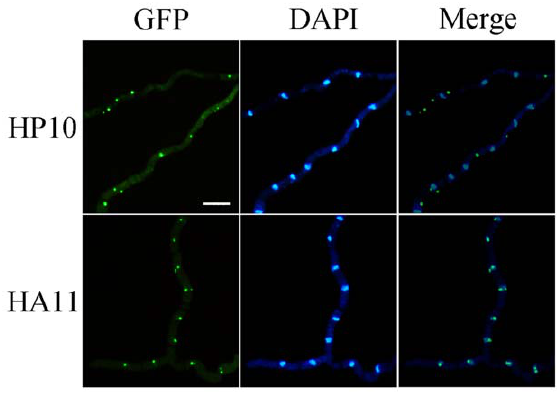
Figure 6. Amt1 regulates the nucleo-cytoplasmic transport of FgHrp1. Fresh conidia were harvested from transformants of PH-1 (HP10) and D amt1 mutant M2 (HA11) expressing the FgHRP1 -GFP fusion construct and incubated in liquid YEPD medium for 12 h. Germ tubes were then stained with DAPI and examined by fluorescence microscopy with the GFP- and DAPI-specific filters. FgHrp1-GFP fusion proteins mainly localized to the nucleus in the D amt1 mutant but to the cytoplasm in the wild type. Bar=20 m m.